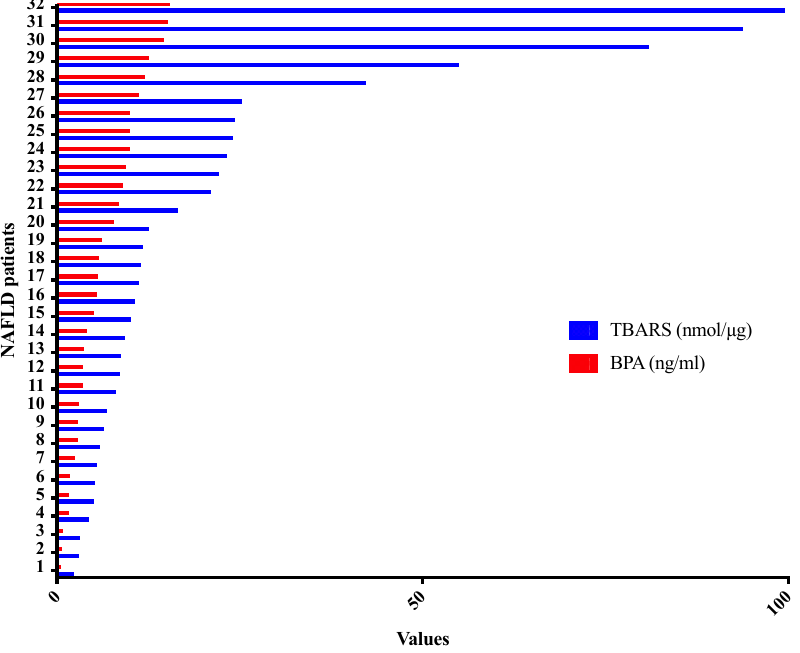
Figure 3. Proportionality relationship between thiobarbituric acid reactive substances (TBARS) and serum bisphenol A (BPA) levels in non-alcoholic fatty liver disease patients ( p < 0.0001). Even if there was a continuous exposure of NAFLD patients to BPA, as confirmed by non ‐ significant variation of plasmatic and urinary levels at T6 in comparison to the baseline ( p = 0.732 and p = 0.915, respectively), the administration of 303 mg of silybin ‐ phospholipids complex, 10 g of vitamin D, and 15 mg of vitamin E led to a significant reduction of TBARS levels at the end of treatment ( p = 0.011) (Figure 4). At the same time the therapy determined in NAFLD patients a statistically significant increase of conjugated BPA (CBPA) urine amount concomitantly with a reduction of its free form ( p < 0.0001, p = 0.0002 respectively) (Figure 5). Moreover, we observed an increase of BPA excretion rate per hour at the end of therapy in comparison to the baseline (T0: 373.1 ± 240.3 ng/mL/h; T6: 465.7 ± 293.1 ng/mL/h; p = 0.019), without a statistically significant modification of daily urine volume or total daily BPA urine amount.